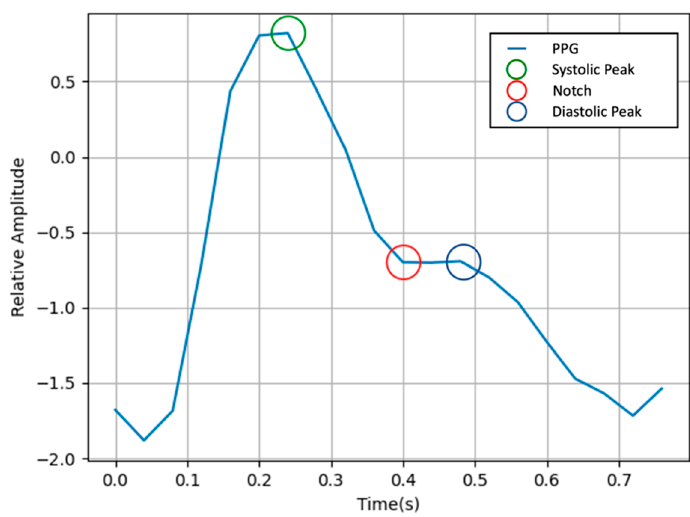
Figure 3. Waveform of a PPG.